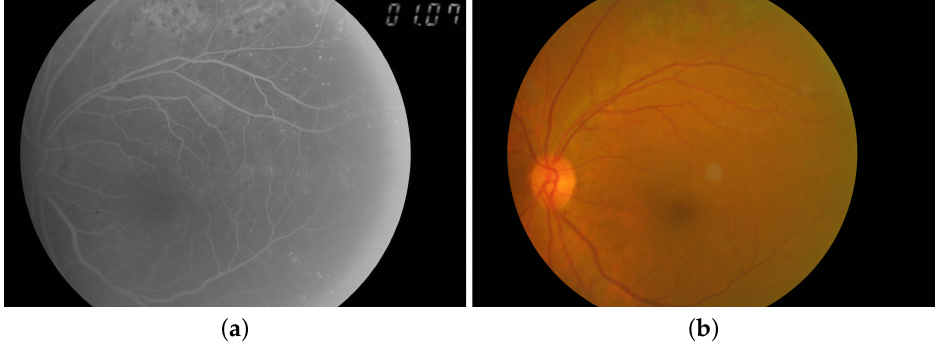
Figure 1. Explanation of the varying-low contrast and noise in fundus images: ( a ) shows the FFA image and ( b ) shows the color fundus image. Note: These images are taken from the FINDeRs UTP Malaysia database